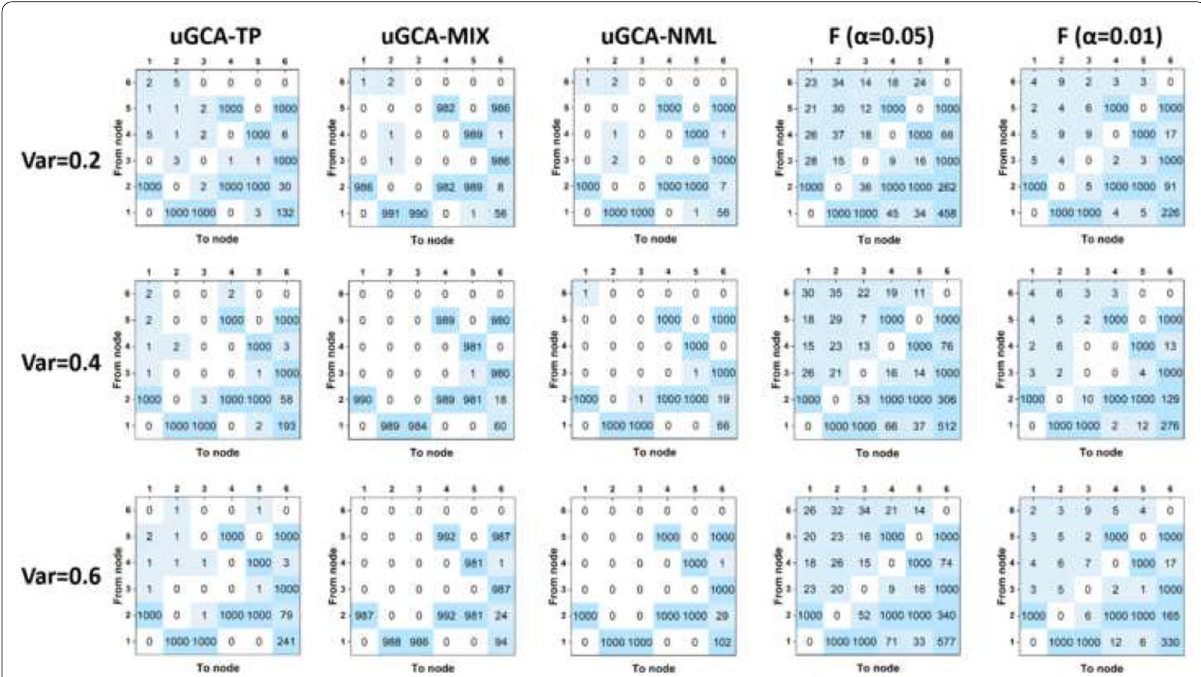
Fig. 2 Causal connectivities obtained by several uGCA forms and conventional GCA. Top row represented results in low noise level (var middle was middle noise level (var